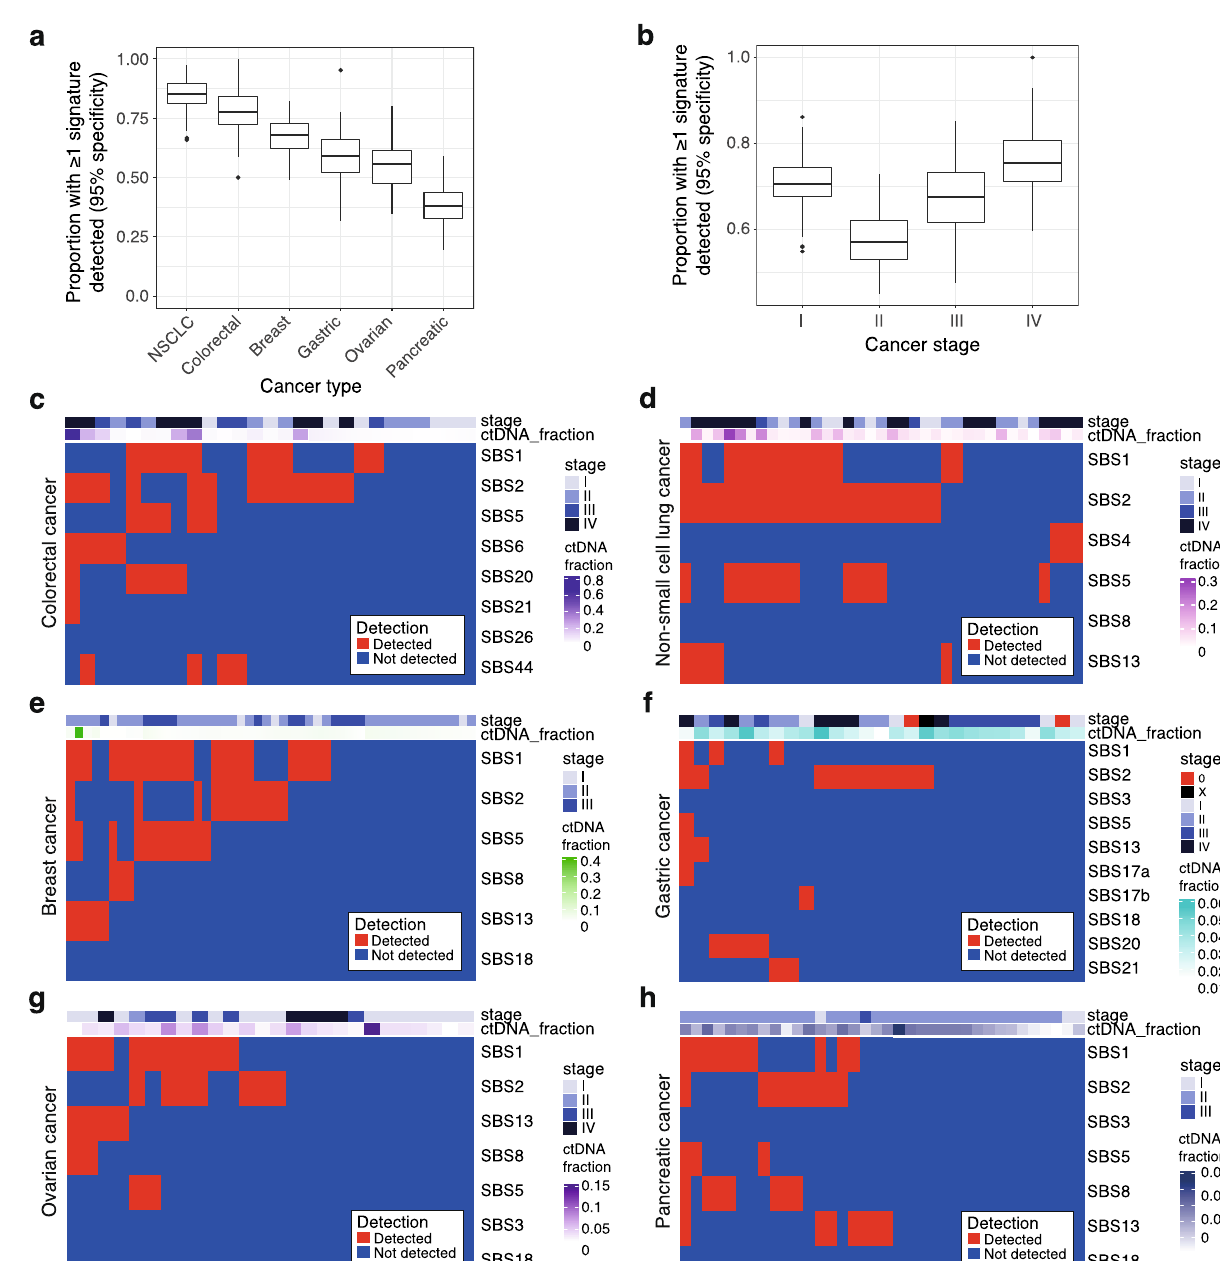
Fig. 4 | Signature pro fi ling of the DELFI cohort. a Boxplots showing the pro- portion of patients from the DELFI cohort ( n =199) with at least one signature detectedinplasma.Dataaresplitbycancertype.Signaturesrelevanttoeachcancer typewereassessedfordetectionwith95%speci fi cityusing10Mreads( “ Methods ” ). Data were bootstrapped with 100 iterations. Boxplots show the bootstrapped median, upper and lower quartiles, and whiskers indicate 1.5× IQR. Outliers are shown as points. NSCLC non-small cell lung cancer. b Boxplots showing the pro- portion of patients with stage I – IV disease from the DELFI cohort ( n =197) with at least one signature detected in plasma are shown. Data are split by cancer stage.